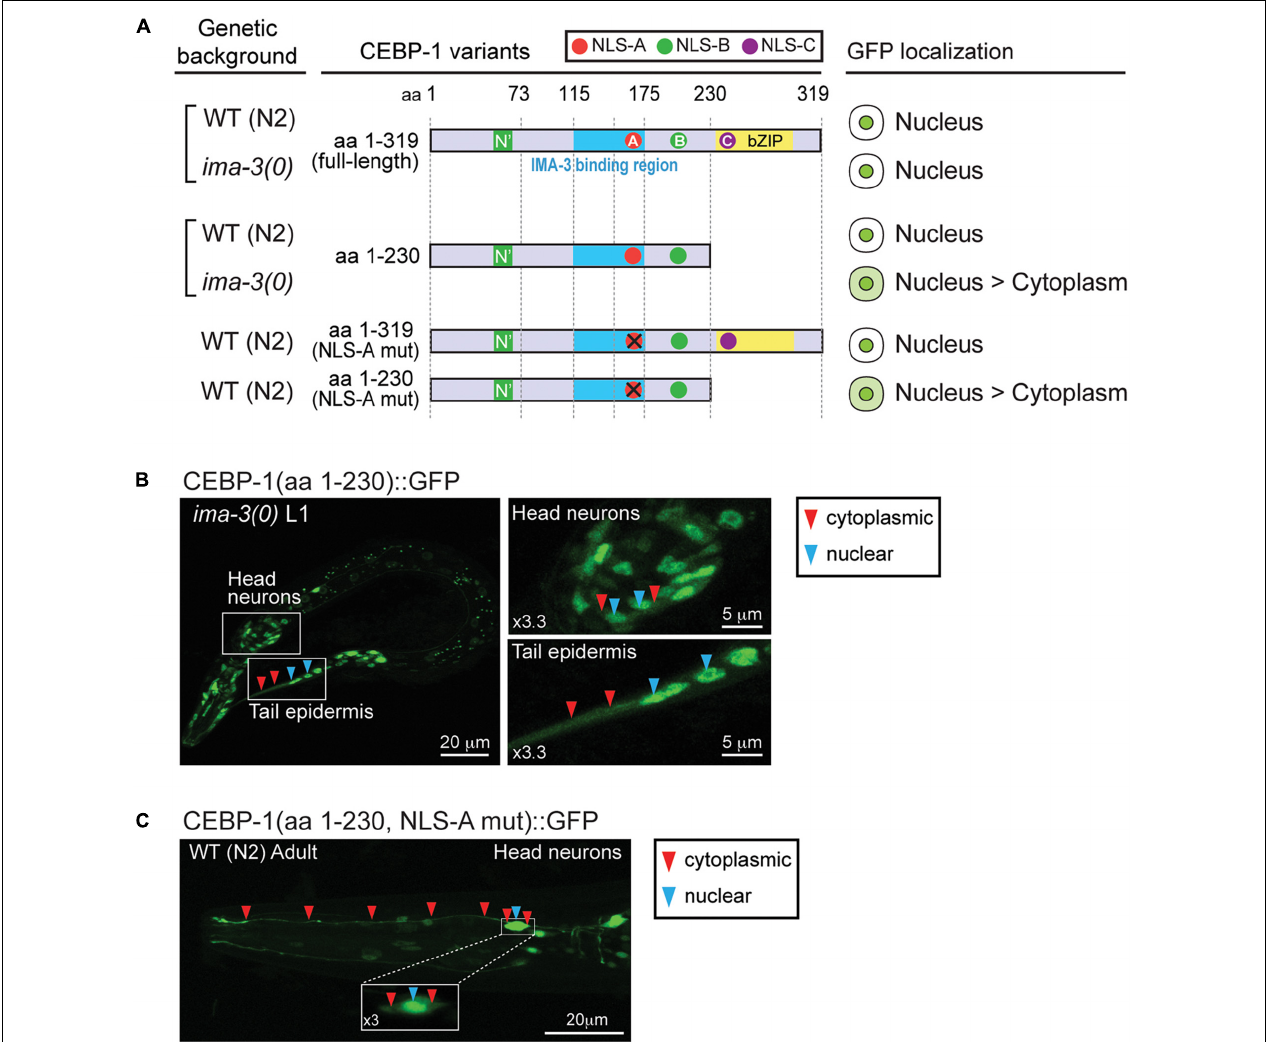
FIGURE 5 | IMA-3 is partly required for CEBP-1 nuclear localization. (A) Subcellular localization of CEBP-1 variants fused to GFP in either wild type (WT) animals or ima-3(ok715) null mutants. (B) Representative image of whole L1 animal of ima-3(ok715) mutants expressing CEBP-1(aa 1–230)::GFP in the ima-3(ok715) mutant; left panels, enlarged images showing both nuclear and cytoplasmic expression of CEBP-1. (C) Representative image of a head part of adult animals expressing CEBP-1(aa 1–230, NLS-A mutation)::GFP in the WT animal; inset: head neuron cell body showing both nuclear and cytoplasmic expression of CEBP-1.